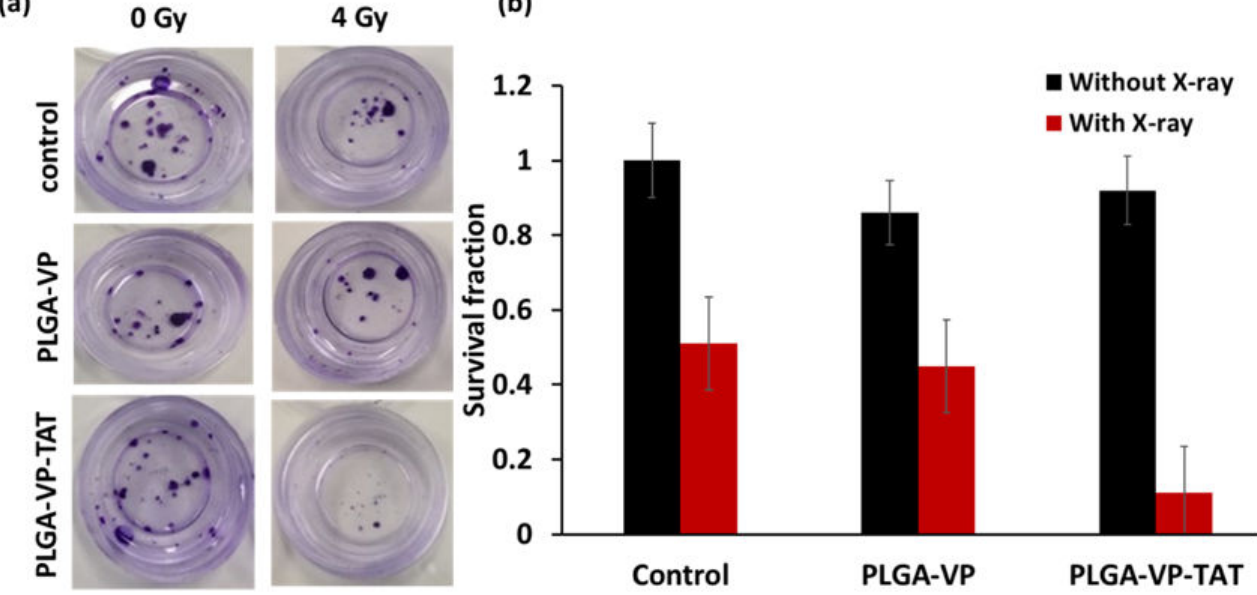
Figure 5. Clonogenic assay. ( a ) example of stained colonies at 14 d following treatment, ( b ) survival fraction for RDT in various treatment